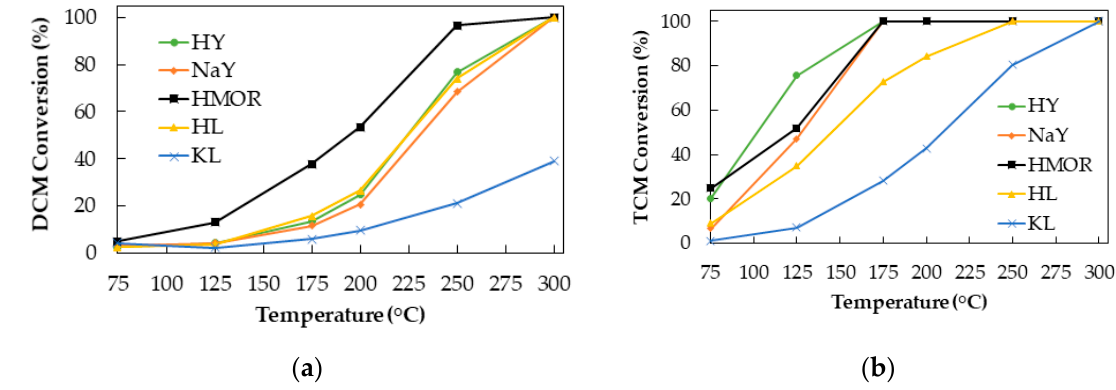
Figure 6. DCM ( a ) and TCM ( b ) conversion versus reaction temperature with the different catalysts ( τ = 0.8 kg h mol − 1 , H 2 / Chloromethane: H 2 / CM molar ratio =